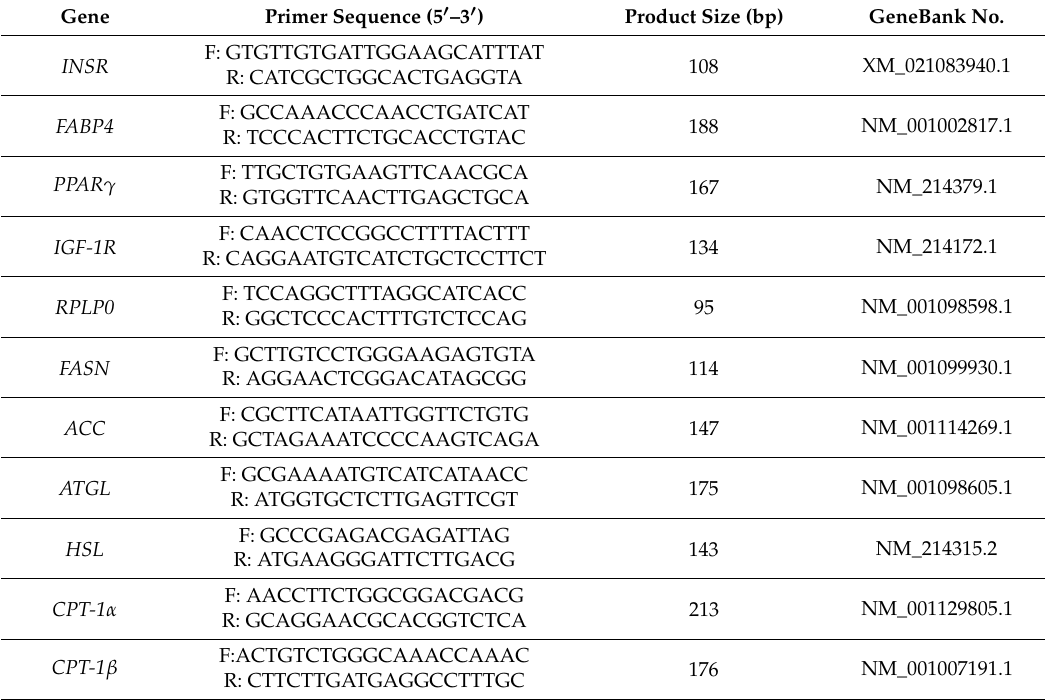
Table 1. Primer sequences of related gene for